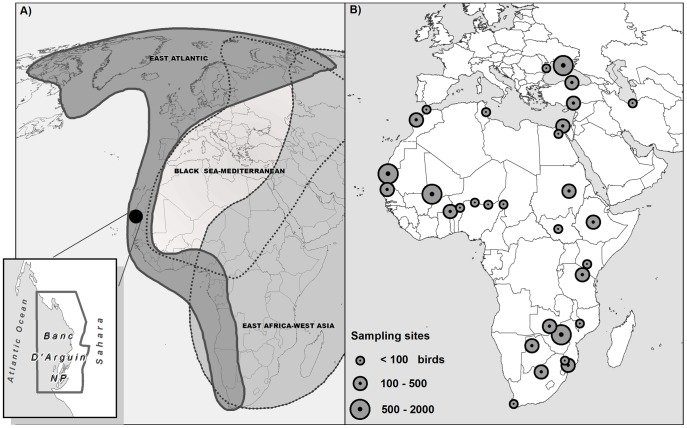
Location of the study sites.(A) The Banc d'Arguin (Mauritania) and the main shorebirds migratory flyways across Western Eurasia and Africa. (B) All shorebird sampling sites considered in our study (list of sites ranked by latitude: Ukraine - Eastern Sivash, Romania-Danube Delta, Turkey - Kizilirmak Delta and Yumurtalik Lagoons, Iran - Fereydoon Kenar marshes, Morocco - Marais du Bas Loukkos and Sidi Moussa-Oualidia Lagoon, Tunisia - Thyna salt pans, Egypt - Nile River Delta and Lake Qarun, Mauritania - Banc d'Arguin National Park, Senegal/Mauritania - Senegal River Delta, Republic of Sudan - El Saggay Island, Mali - Inner Niger Delta, Niger - Kurfunkura pond and Gaya, Chad - Lake Chad, Nigeria - Hadejia-Nguru wetlands, Burkina Faso - Lake Kompienga, Ethiopia - Lake Debre Zeit, South Sudan - Bargel wetland, Kenya - Lakes around Nairobi, Tanzania - Lake Manyara, Malawi - Lake Chilwa, Zambia - Kafue Flats, Zimbabwe - Lakes Manyame-Chivero, Botswana - Lake Ngami, Mozambique - Massingir Dam and Lake Chuali, South Africa - Barberspan wetland and Strandfontein). A detailed list of sampling sites is provided in the supporting information Table S2 (map by M. Gély ©Cirad).